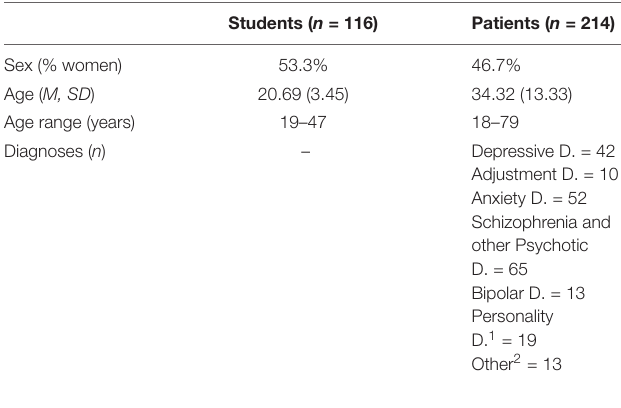
TABLE 1 | Sample sociodemographic characteristics and clinical